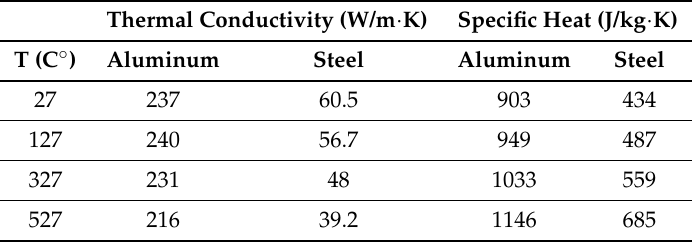
Table 3. Variations of k c and c p with T for aluminum and